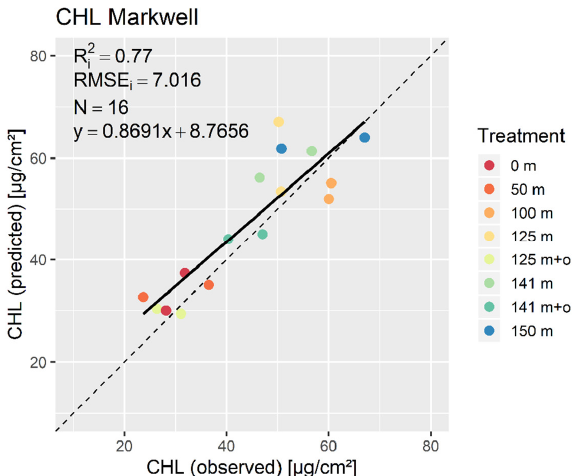
Figure 8. Scatterplot of independently validated PLSR models for chlorophyll (CHL) with the regression line (continuous) and the 1:1 line (dashed). line (continuous) and the 1:1 line (dashed).